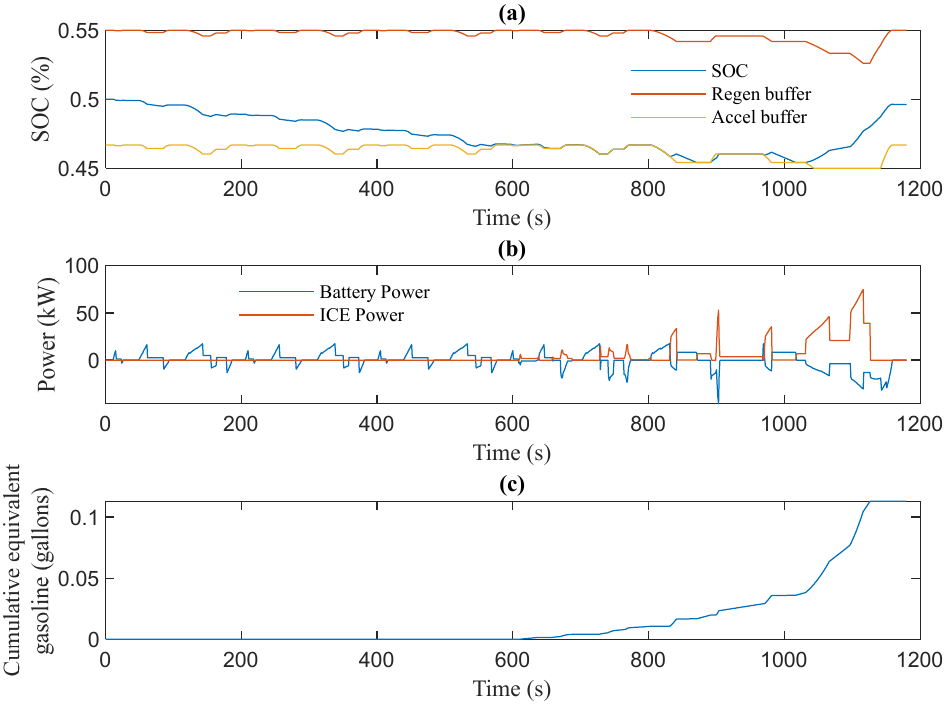
Figure 5. FASTsim simulation results for the HEV of [42] for NEDC cycle. ( a ) Battery SOC; ( b ) powers of the battery and the ICE; ( c ) cumulative equivalent gasoline consumption in gallons.